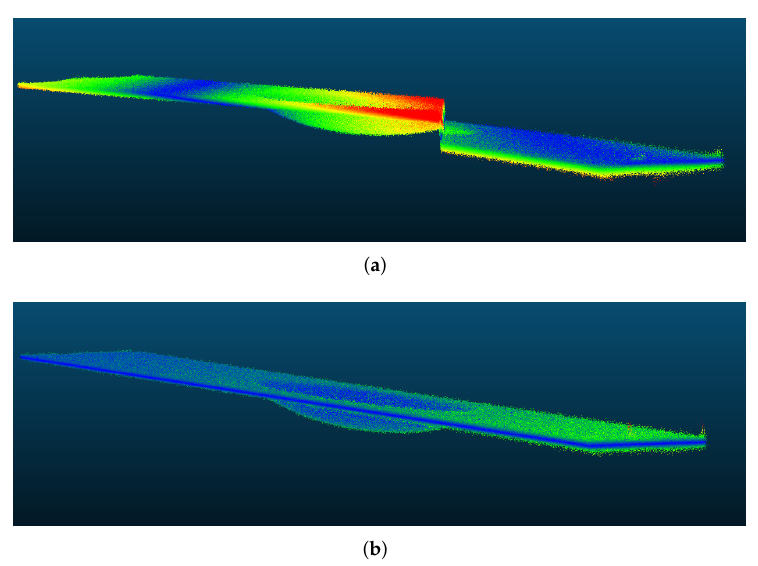
Figure 13. Comparison of 3D reconstruction of the simulated dent (as heatmap of MAE) using Estrada’s noise-robust algorithm ( τ = 0.8) with the ( a ) direct mapping method and the ( b ) proposed virtual reference